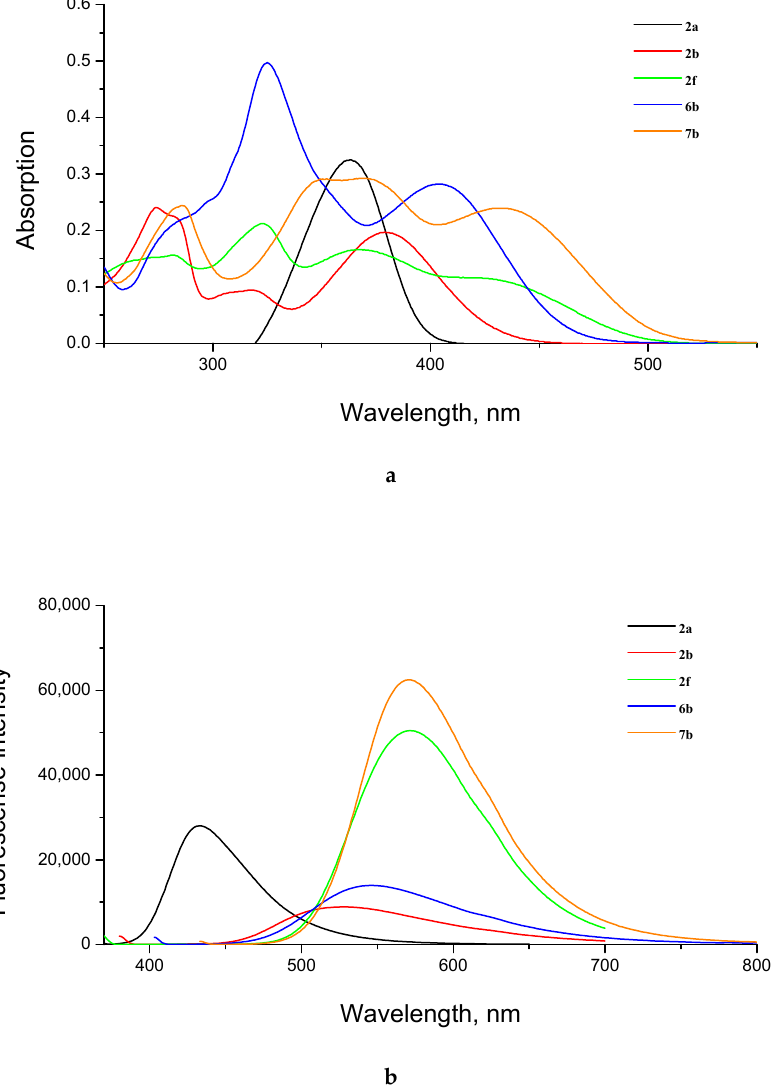
Figure 4. Absorption ( a ) and emission ( b ) spectra of compounds 2a,b,f; 6b; and 7b in MeOH (C = 1.0 × 10 − 5 M).